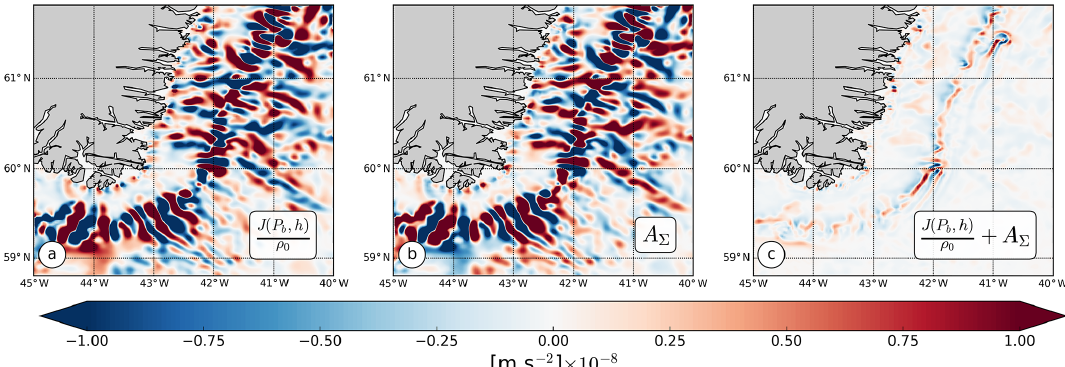
Figure 6. Time-mean (a) bottom pressure torque, (b) nonlinear terms, and (c) the sum of the two for eastern Greenland in the 2km North Atlantic subpolar gyre simulation.